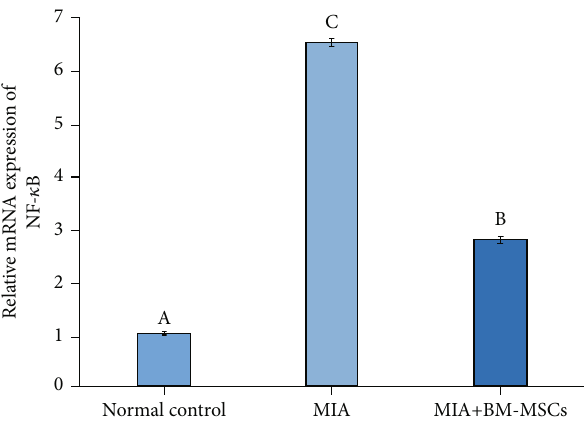
Figure 4: E ff ect of BM-MSC treatment ( 5 × 10 6 cells/rat) on the mRNA expression level of NF- κ B in MIA-induced animals. Means, which have di ff erent symbols, are signi fi cantly di ff erent at P < 0 : 05